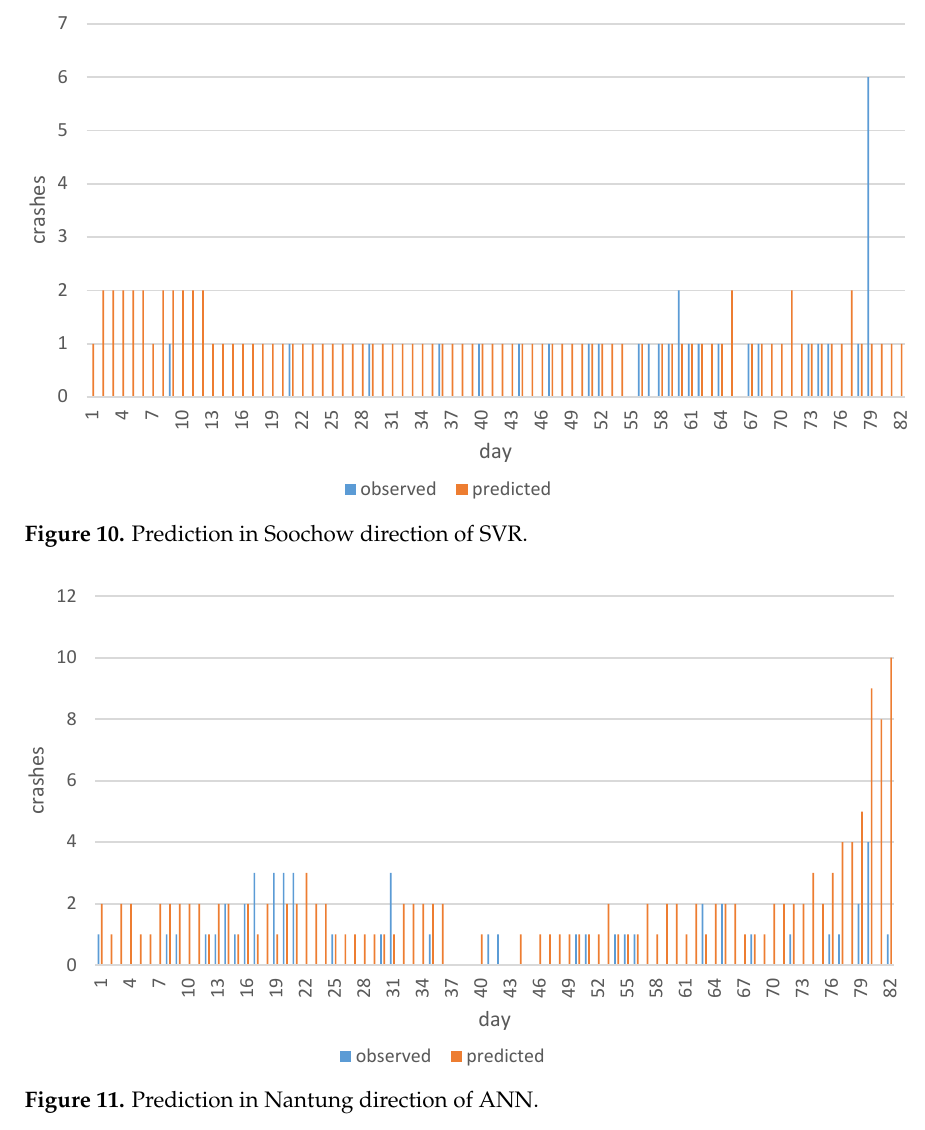
Figure 11. Prediction in Nantung direction of ANN. Figure 13. Prediction in Nantung direction of ANN.